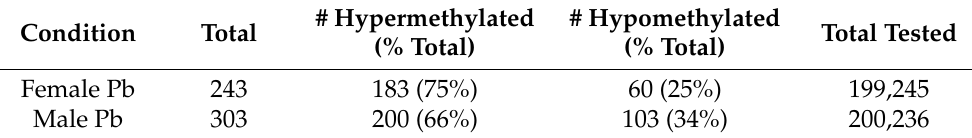
Table 2. Differentially methylated regions (DMRs) in 5 month offspring mouse hearts.